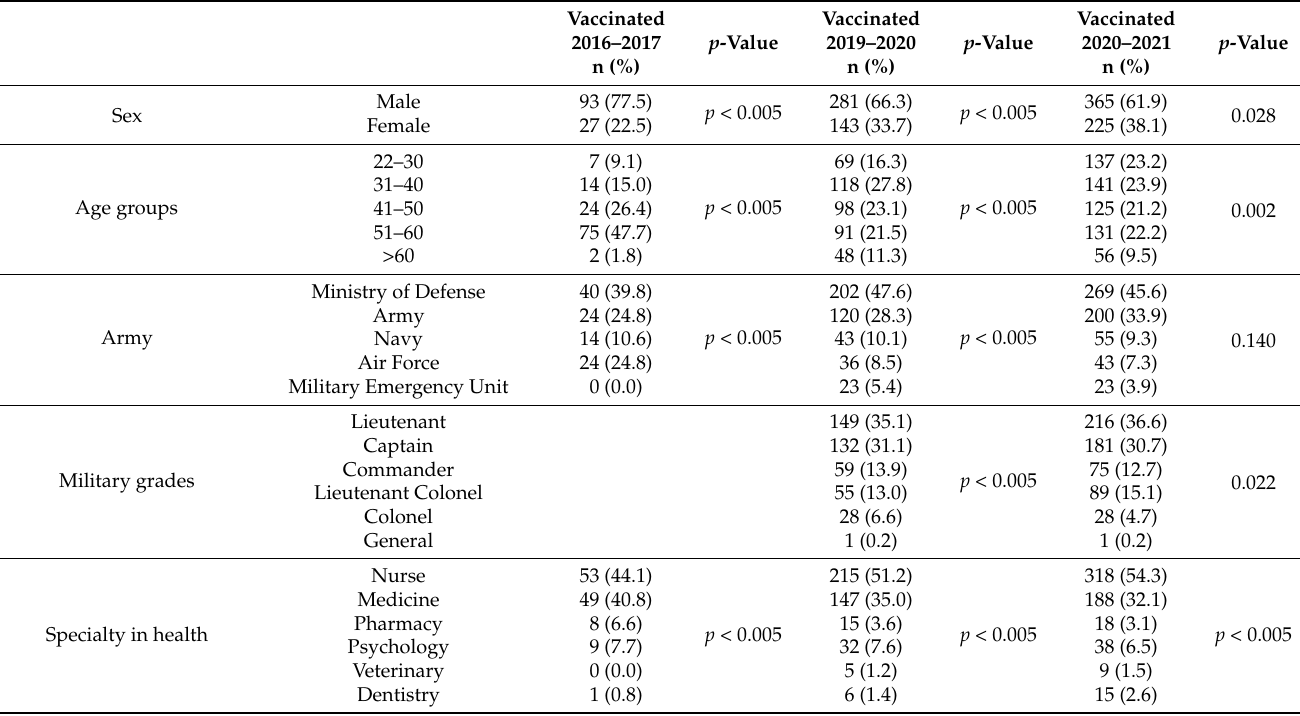
Table 1. Influenza vaccination coverage against seasonal influenza in CMS according year